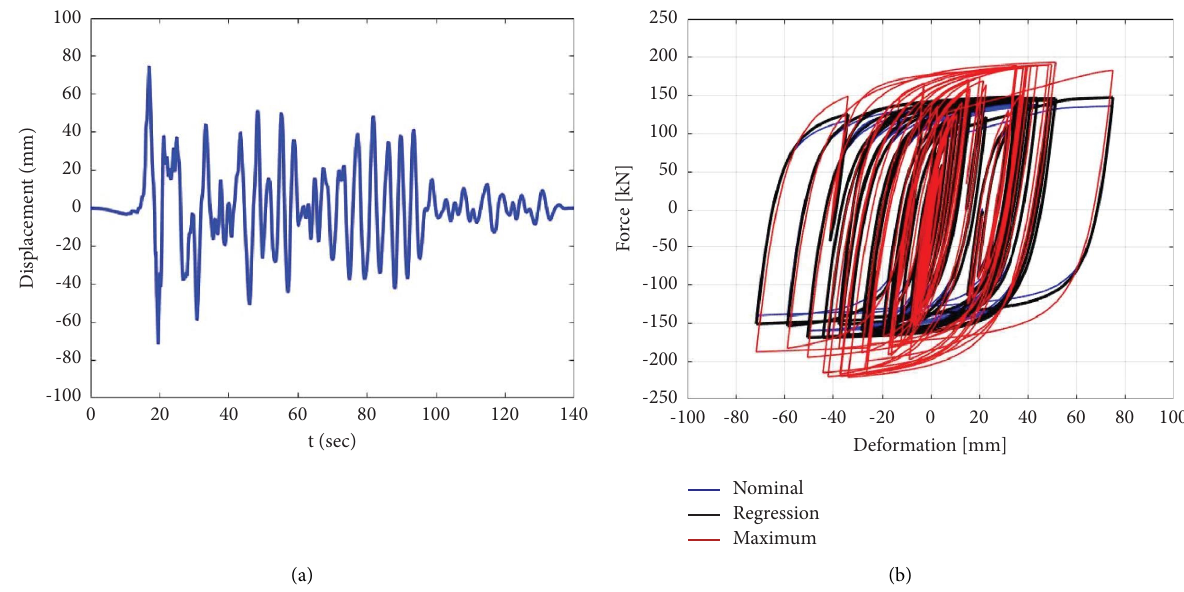
Figure 9: ID1100: applied displacements (a) and hysteresis curves